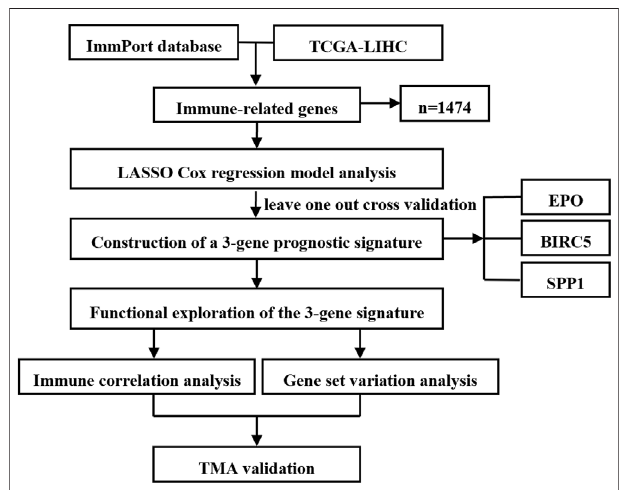
FIGURE 1 | Flow chart of study